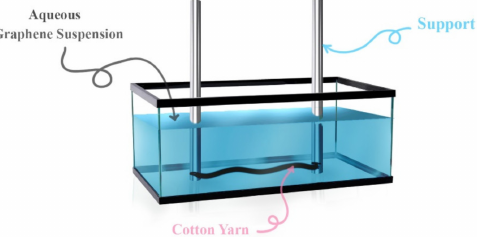
Figure 6. Schematic representation of the device used for the coating of cotton yarns with graphene sheets [130].